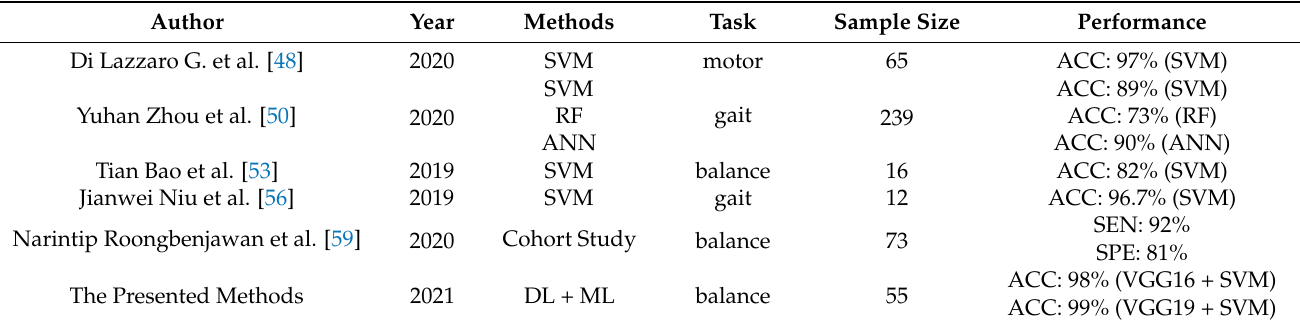
Table 6. Comparison of the proposed methods with methods developed in related